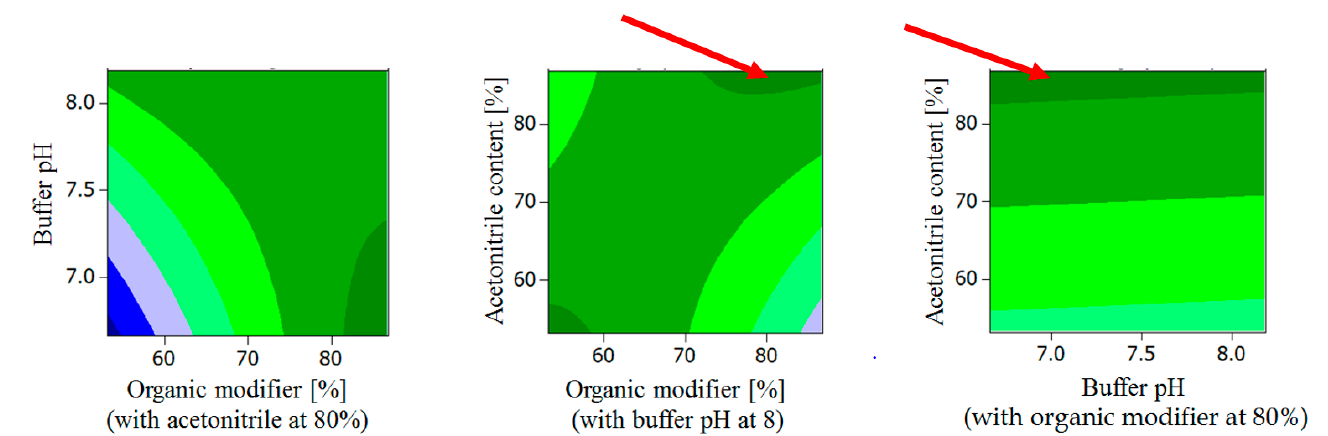
Figure 3. Response surface contour plots for R s2 : the dark green plot regions represent those of the highest R s . The red arrows indicate the “global solution” predicting the optimum chromatographic conditions for highest R s (see Section 2.1.5).